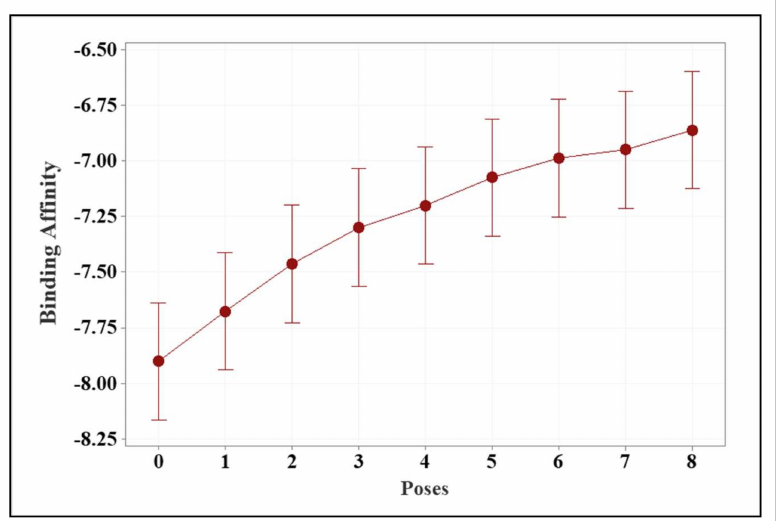
Figure 7. Interval plot of the binding affinities of the nine poses. The interval plots for the binding affinities of the synthesized ligands and the approved drugs were blotted for the interval calculated using a pooled standard division at a confidence level of